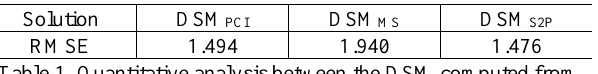
Table 1. Quantitative analysis between the DSM computed from the selected solutions and the LiDAR-DSM (meter)